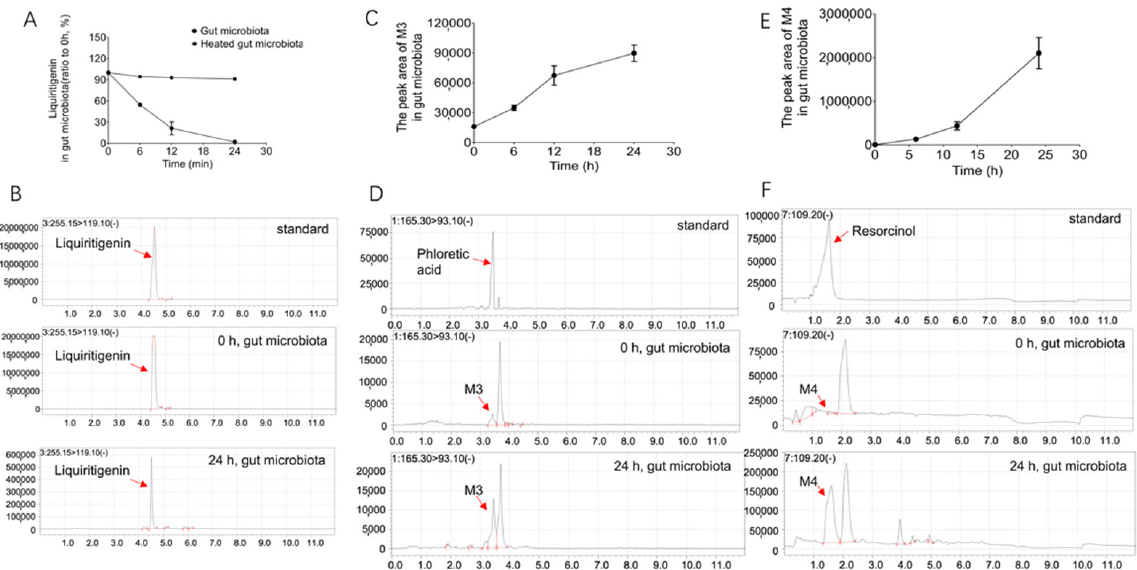
Figure 2. The metabolites of liquiritigenin from the gut microbiota. ( A ): The relative abundance of liquiritigenin after incubation with rat gut microbiota and heated gut microbiota for 0 h, 6 h, 12 h, and 24 h; ( B ): EIC of the standard liquiritigenin and EICs of liquiritigenin after 0 h and 24 h of incu- bation in the rat gut microbiota system; ( C , E ): time-dependent curves of metabolites M3 and M4 after incubation with rat intestinal flora for 0 h, 6 h, 12 h, and 24 h; ( D , F ): EICs of the standard phloretic acid and resorcinol and EICs of metabolites M3 and M4 after 0 h and 24 h of incubation in the rat intestinal flora system.